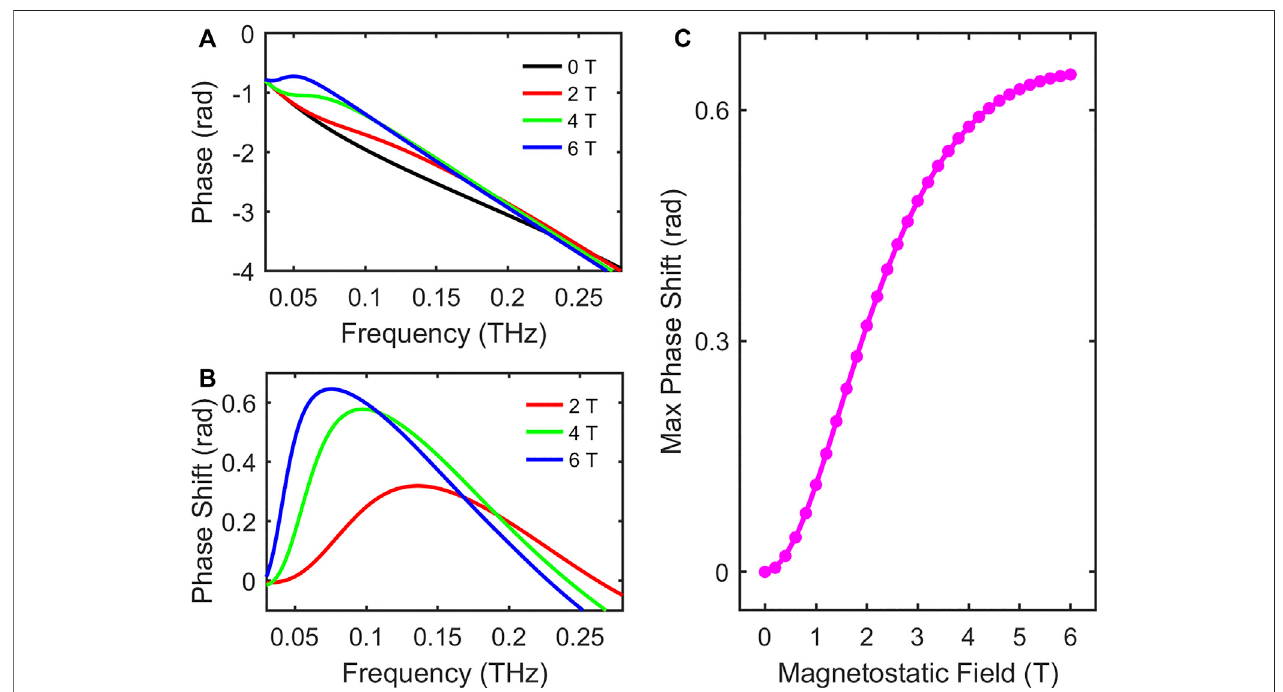
FIGURE 4 | (A) ThetransmittedphasespectraofthegrapheneTHzmetasurfaceunderdifferentexternaluniformmagnetic fl uxdensitiesapplied. (B) Thedifferencebetweenthe transmittedphasecurvesof B 0 (cid:2) 2 T/4 T/6 Tandthetransmittedphasecurveof B 0 (cid:2) 0 T. (C) Themaximumofphaseshiftasafunctionofthevaluesofthemagnetic fl uxdensityapplied.